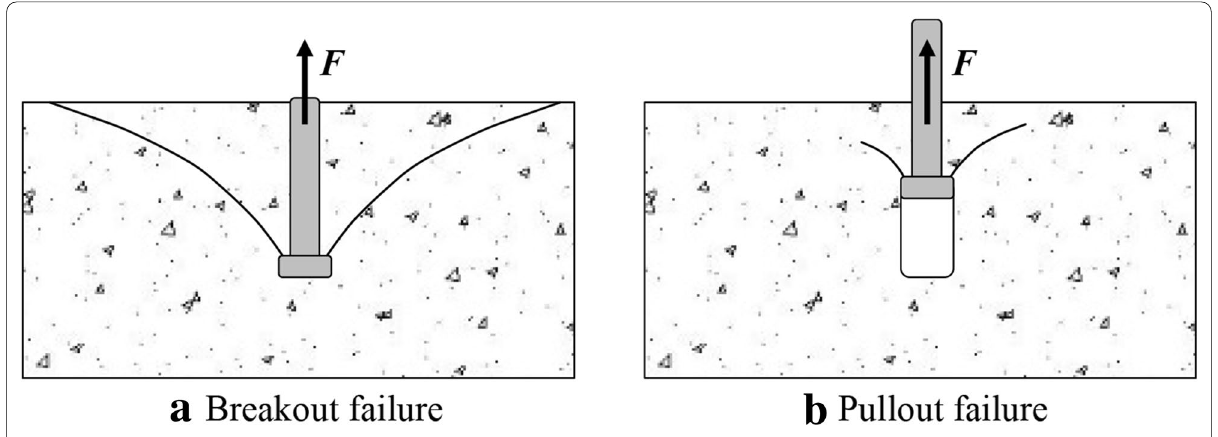
Fig. 2 Failure modes of the anchorage